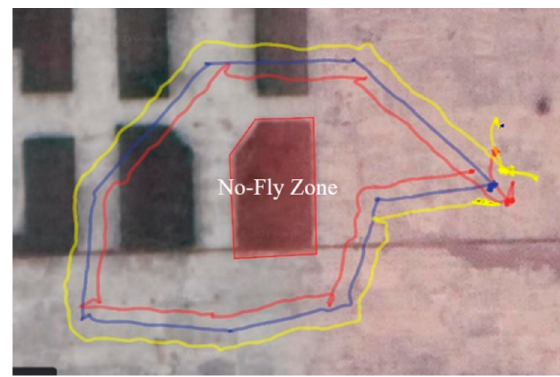
Figure 20. Formation flight experiment results.